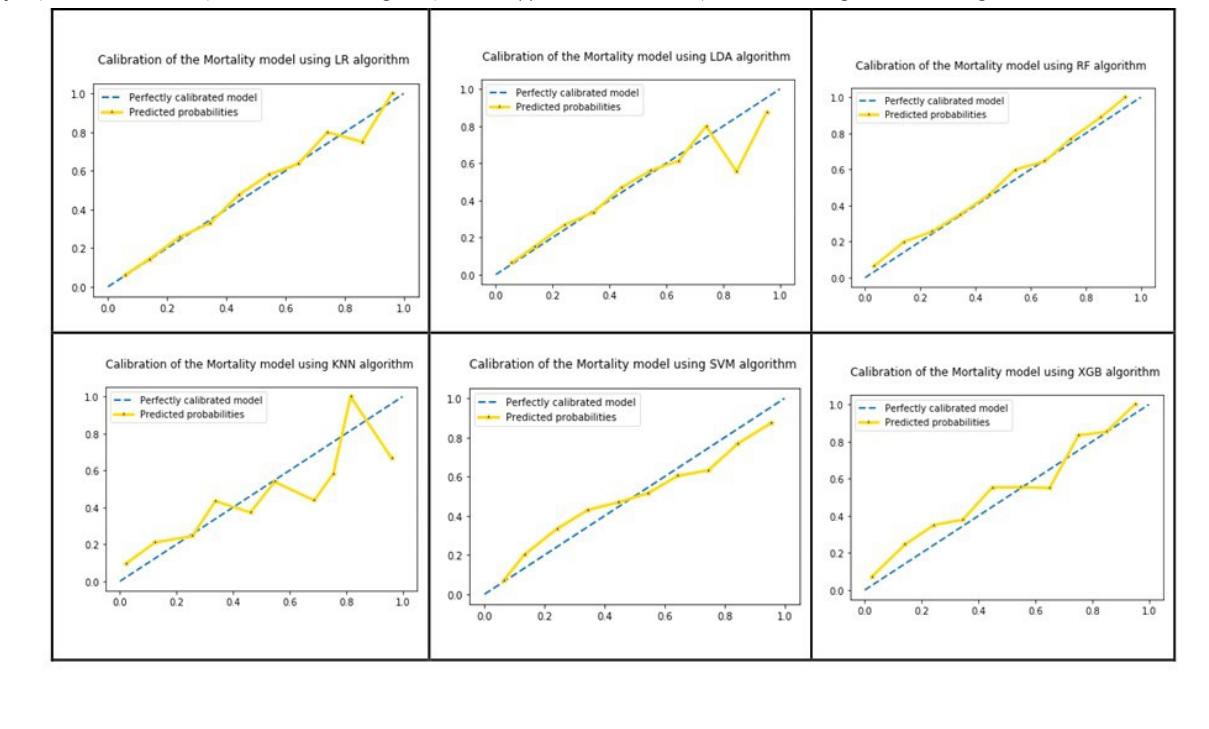
Figure 10. Probability calibration curves of the mortality model for the six classification algorithms. LR: logistic regression; LDA: linear discriminant analysis; RF: random forest; KNN: k-nearest neighbor; SVM: support vector machine; XGB: extreme gradient